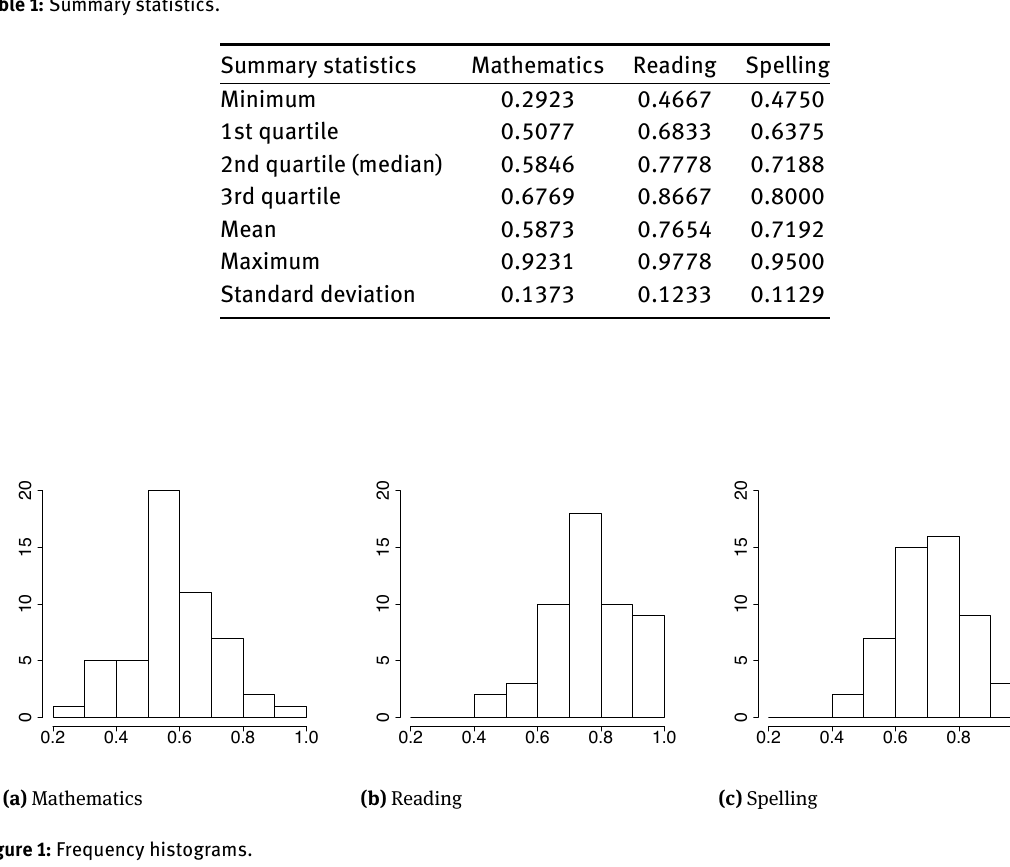
Table 1: Summary statistics.